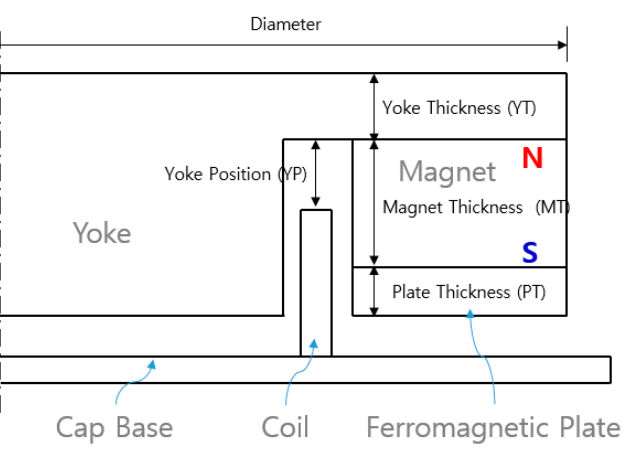
Figure 5. Design cross ‐ section and design parameters of vertical magnetized structure.